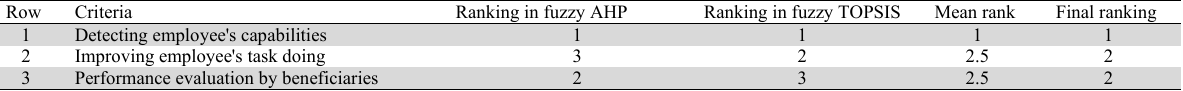
The results of final ranking of performance evaluation sub-criteria Row Criteria Ranking in fuzzy AHP Ranking in fuzzy